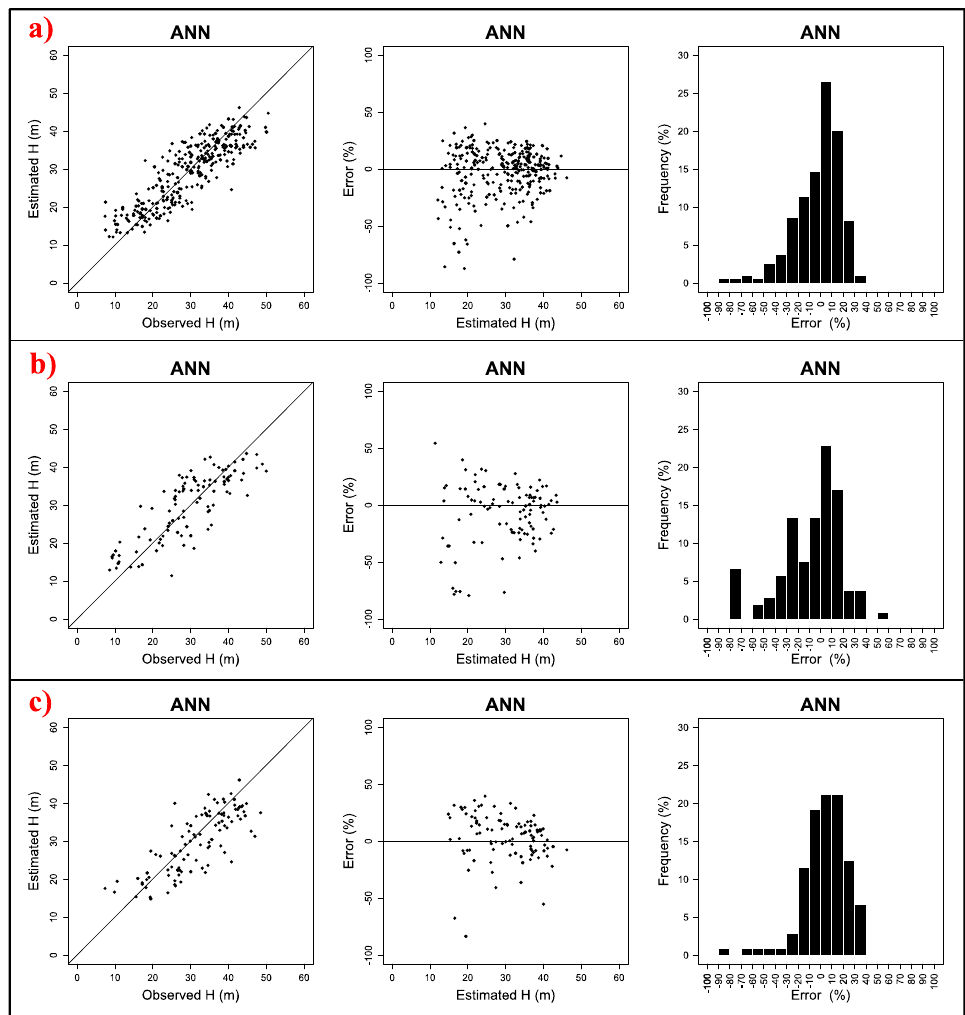
Figure 7. Estimated heights versus observed heights, distributions of percentage errors of height estimates, and histograms of errors of height estimates, obtained by ANN, for training ( a ), validation ( b ), and test ( c ) data.